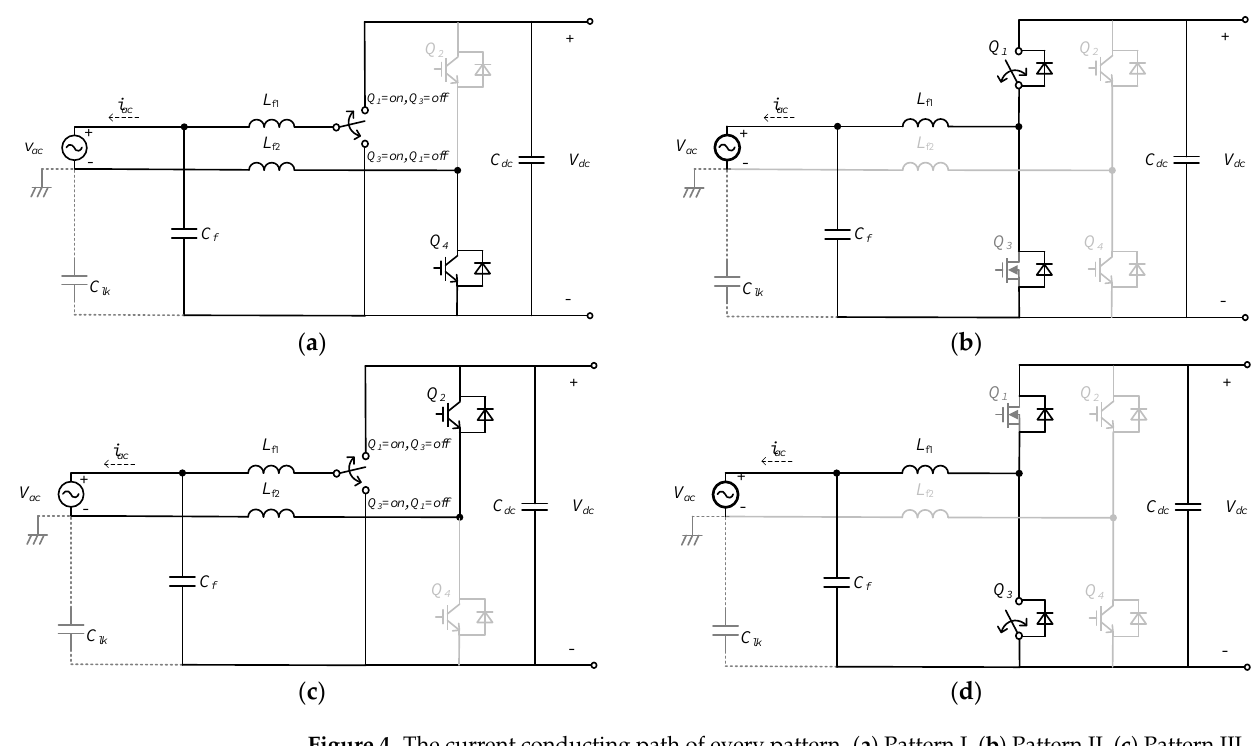
Figure 4. The current conducting path of every pattern. ( a ) Pattern I, ( b ) Pattern II, ( c ) Pattern III, and ( d ) Pattern IV.